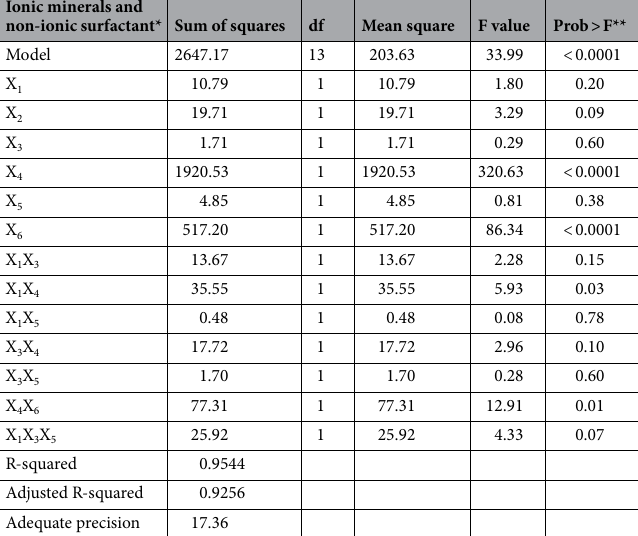
Ionic minerals and non-ionic